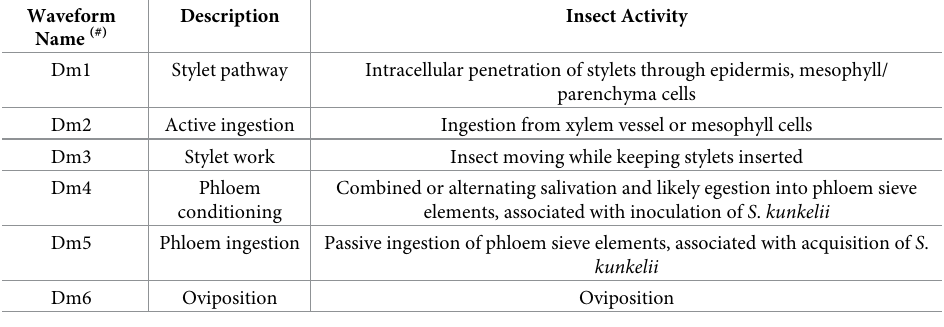
Table 1. Updated waveforms names / biological meanings according to Carpane et al. 2011 (ref no. 27 in this